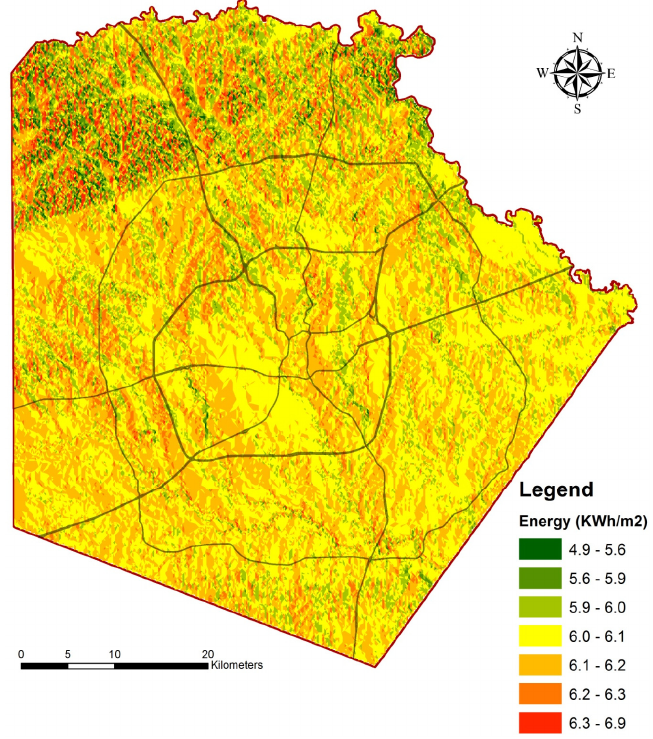
Figure 9. Distributed solar energy potential in Bexar County (calculated from direct irradiance on 21 March, 21 June, 23 September and 22 December at morning, noon and afternoon hours of each day).